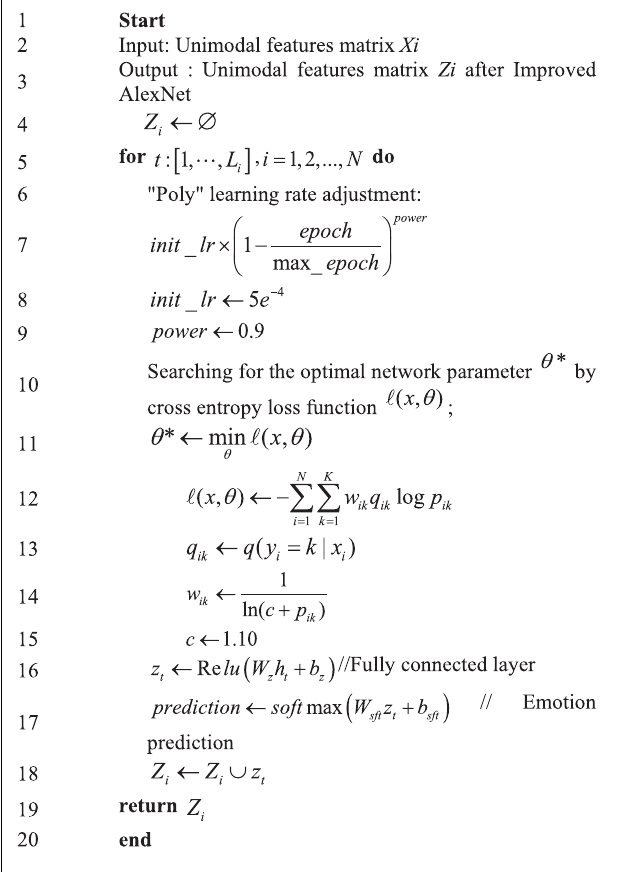
FIGURE 5 | Procedures of the proposed algorithm based on Chi Square Test and improved